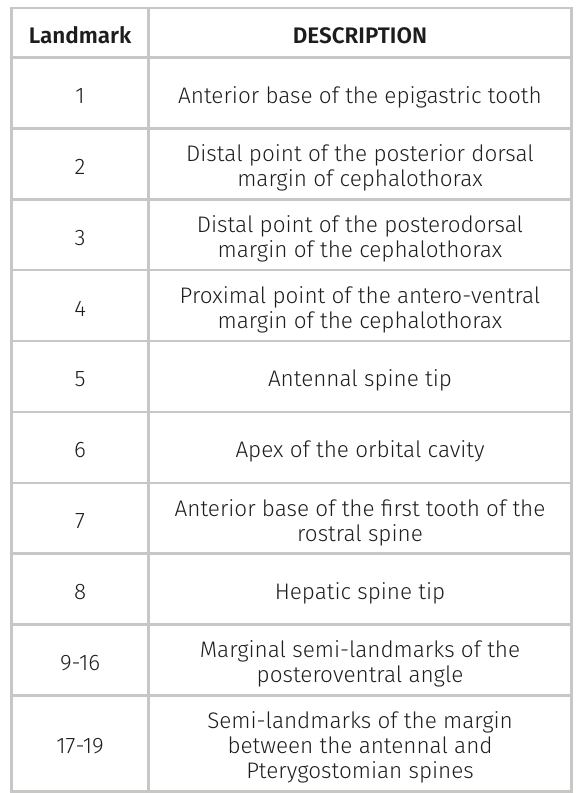
Table I. List of landmark descriptions used in the investigation of the variation of the cephalothorax shape of Litopenaeus schmitti (Burkenroad, 1936) and L. vannamei (Boone,